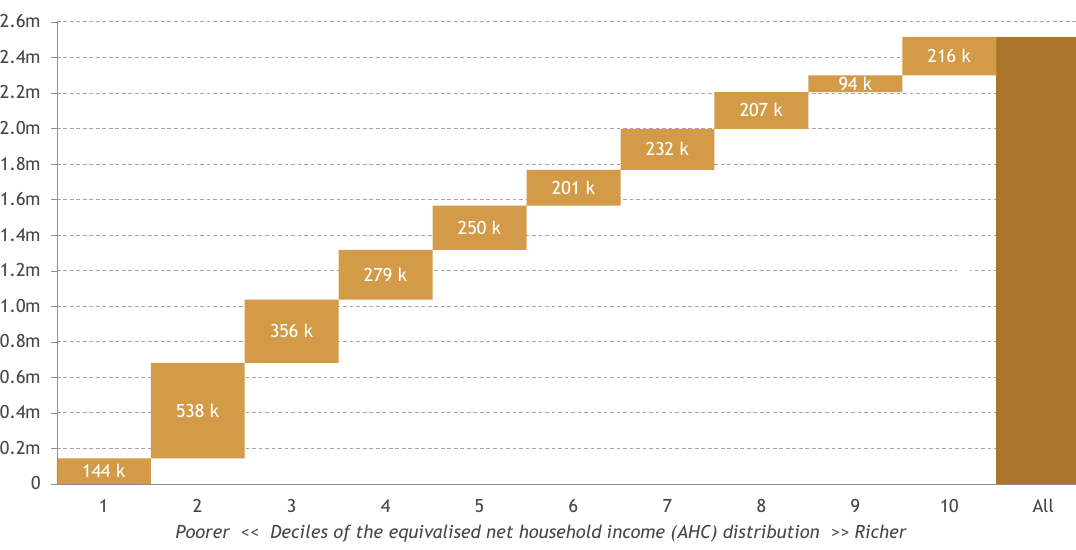
Figure 12: People in the bottom half of the income distribution accounted for nearly two-thirds of the increase in employment since 2007-08 Change in employment by household income decile: